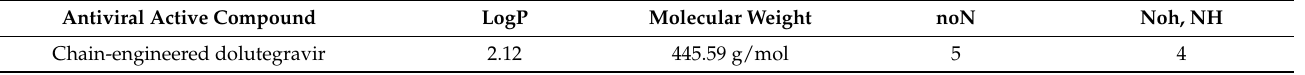
Table 4. Description of parameters in the valuation of Lipinski’s rule.